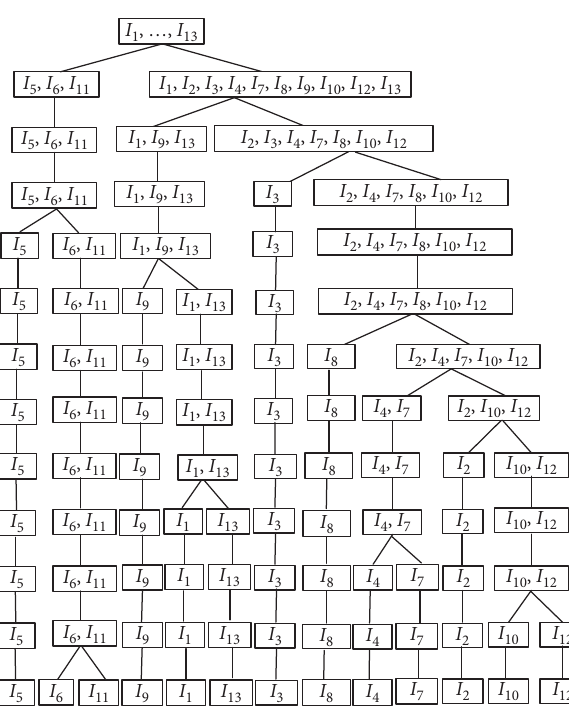
Figure 4: Cluster analysis of random insertion of 9